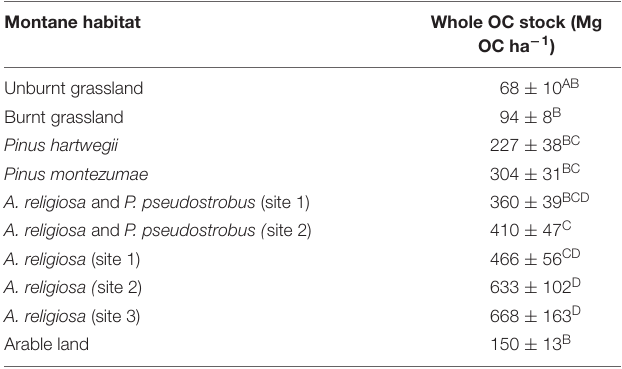
TABLE 6 | Whole organic carbon stocks (Mg OC ha − 1 ) at our studied montane habitats within the Nevado de Toluca Flora and Fauna Conservation Area, State of Mexico,